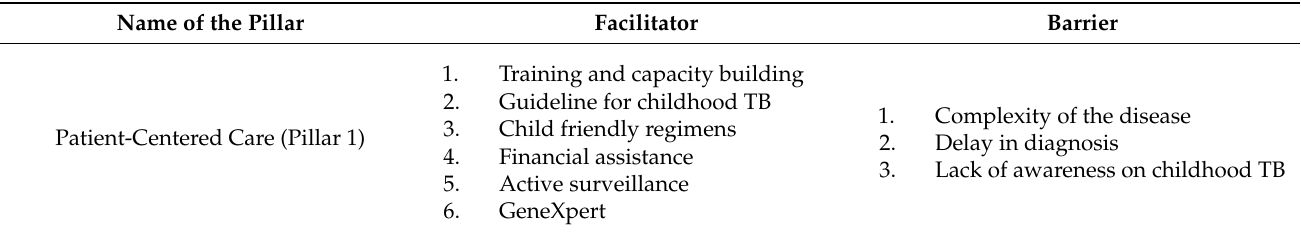
Table 4. Facilitators and Barriers to diagnosis and treatment of childhood TB in Bangladesh. Name of the Pillar Facilitator Barrier